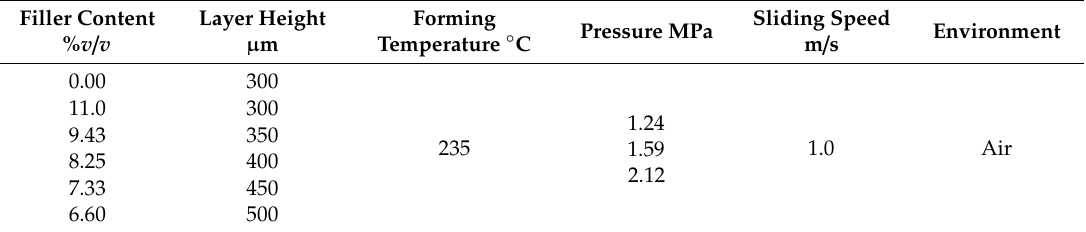
Table 4. Experiment parameters II.